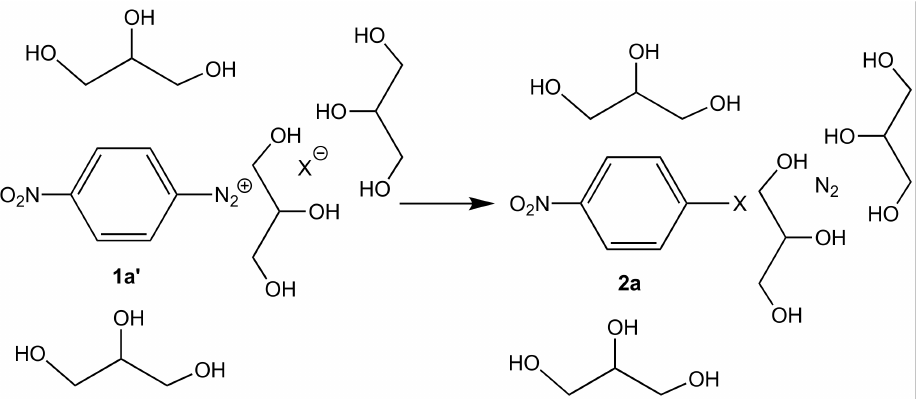
Scheme 3. The halogenation of the solvated 4-nitrobenezenediazonium 1a’